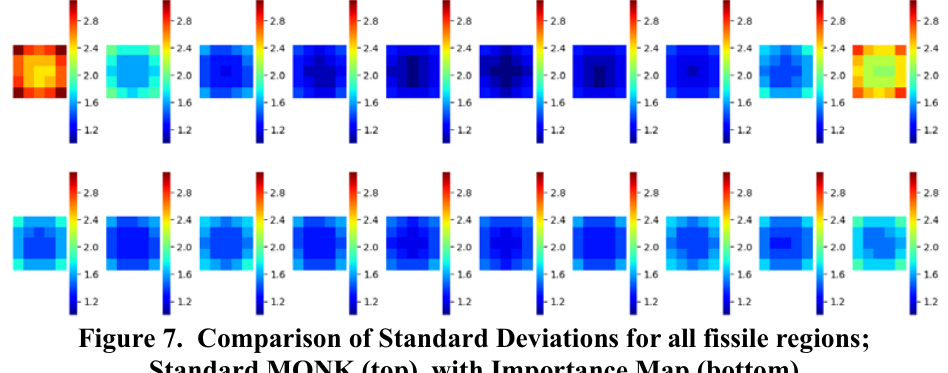
Figure 7. Comparison of Standard Deviations for all fissile regions;